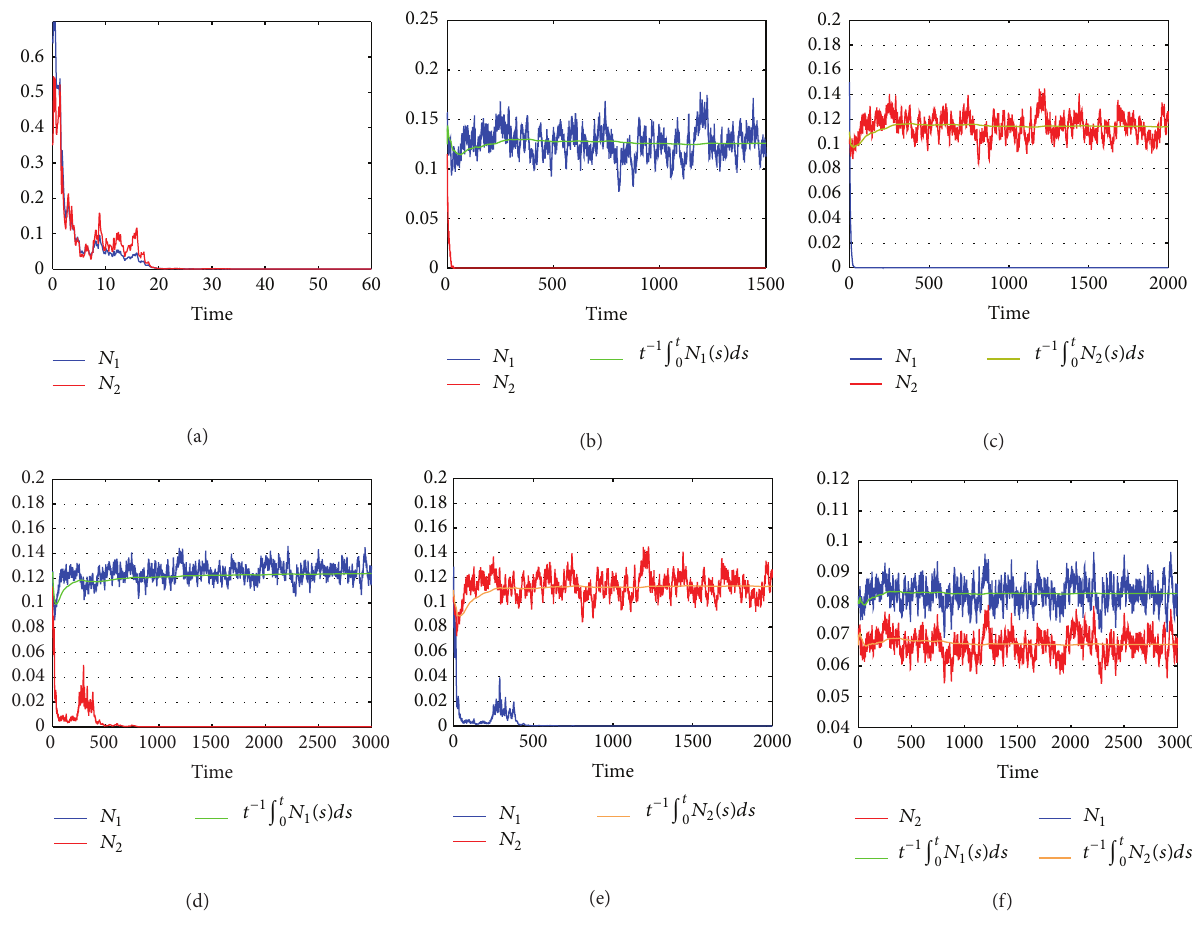
Figure 1: Solutions of system (1) for 𝑟 10 = 0.7 , 𝑟 20 = 0.5 , 𝑎 11 = 0.8 , 𝑎 12 = 0.5 , 𝑎 21 = 0.4 , 𝑎 22 = 0.7 , 𝜏 1 = 10 , 𝜏 2 = 12 , 𝑘 = 𝑔 = 𝑚 = 0.2 , ℎ = 0.5 , 𝑏 = 0.1 , 𝛾 = 1 , 𝐶 = 0.8 ; (d) is with 𝜆 𝜆 2